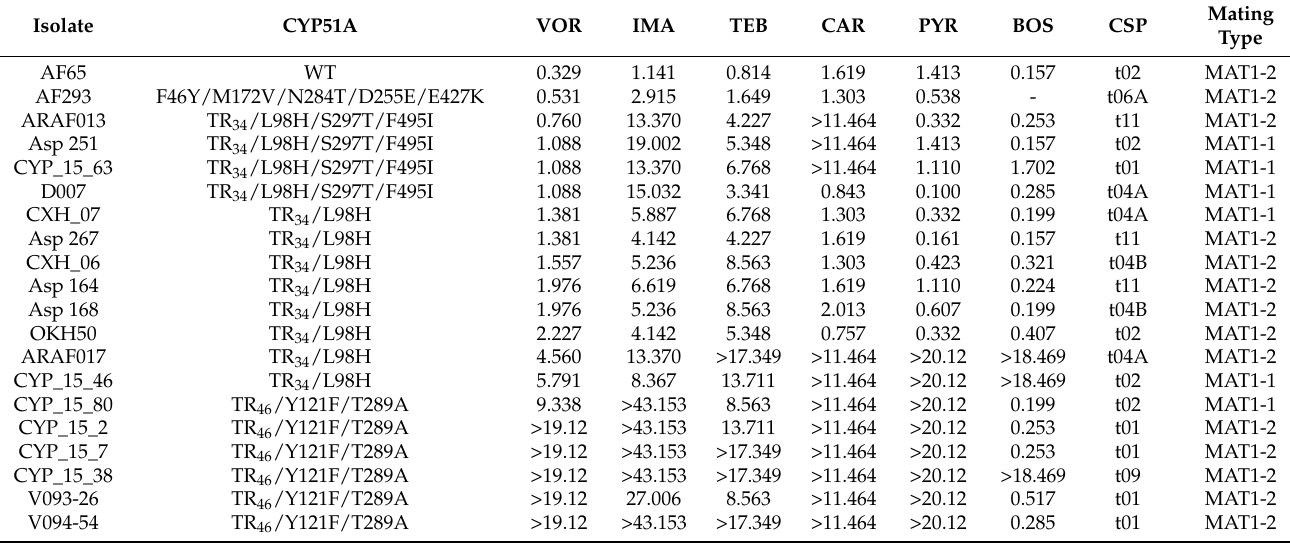
Table 3. Sensitivity of clinical Aspergillus fumigatus isolates to a panel of fungicides belonging to different modes of action and their further characterization using CSP, mating type and CYP51A variant analysis. Isolates ranked according to voriconazole sensitivity (low to high MIC values in µ